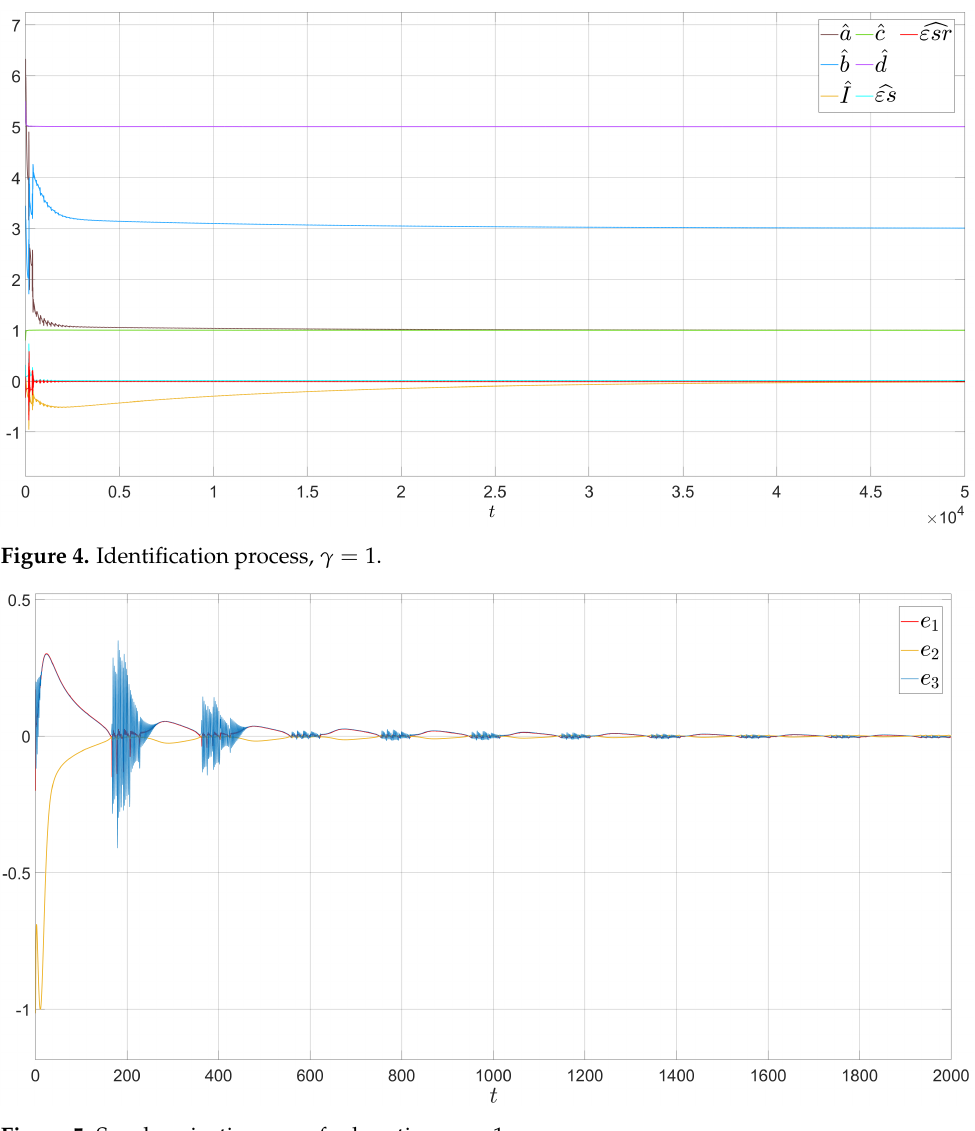
Figure 5. Synchronization error for bursting, γ =